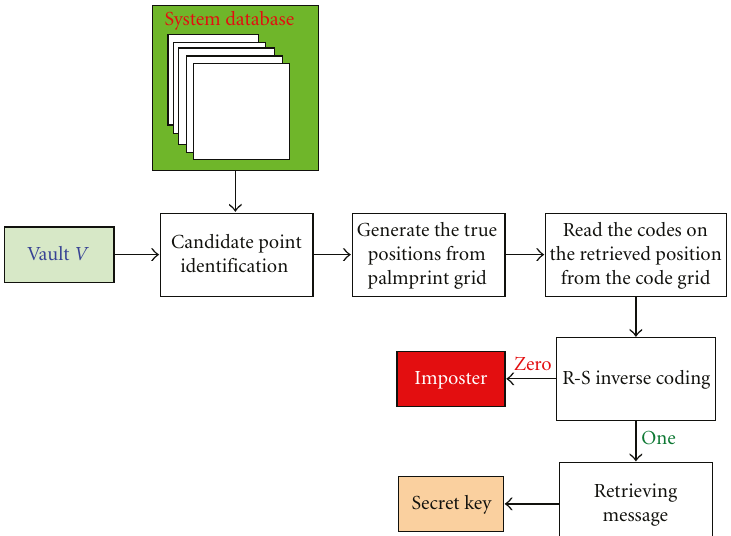
Figure 3: Block diagram for unlocking of the vault.